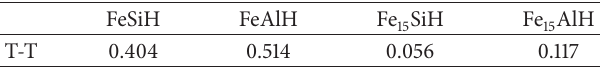
Table 7: Diffusion barrier of hydrogen in the system with silicon